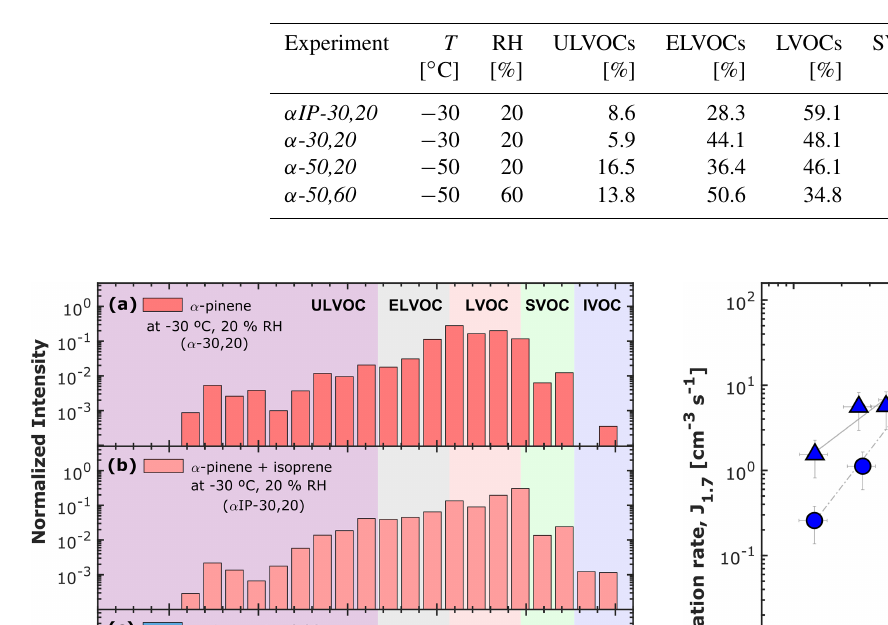
Table 2. Bin volatility fractions for the different experiments.